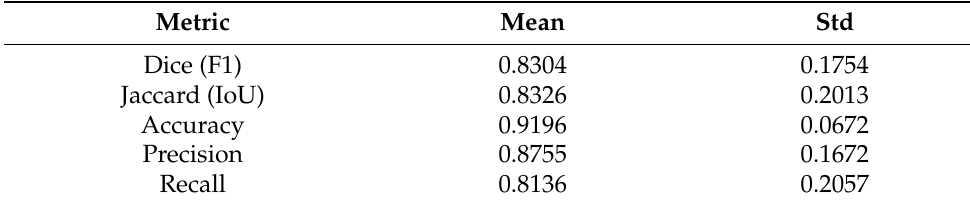
Table 1. Mean Performance metrics values for the F1 score, Jaccard index, Accuracy, Precision, and Recall of the retrained TernausNet16 model respectively. The column mean shows the mean values and std contains standard